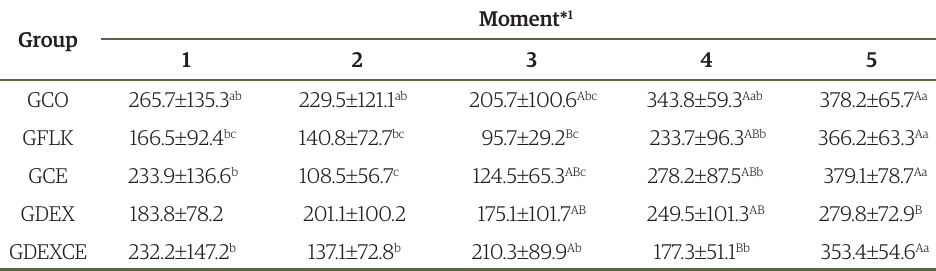
Table 5. Cortisol values (nmol/L) between moments in the groups.